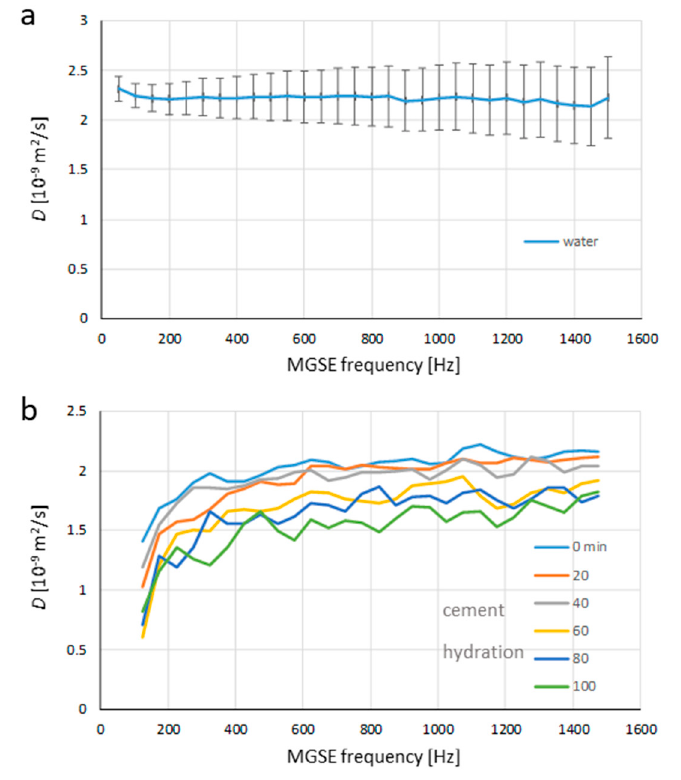
Figure 2. Diffusion spectra of ( a ) bulk water and ( b ) white cement paste at different time durations after the onset of cement hydration. The measurement illustrates that the water sample had a flat spectrum (constant diffusion) over the entire range of the examined frequencies, while the spectra of cement paste samples were not flat and kept evolving over time.